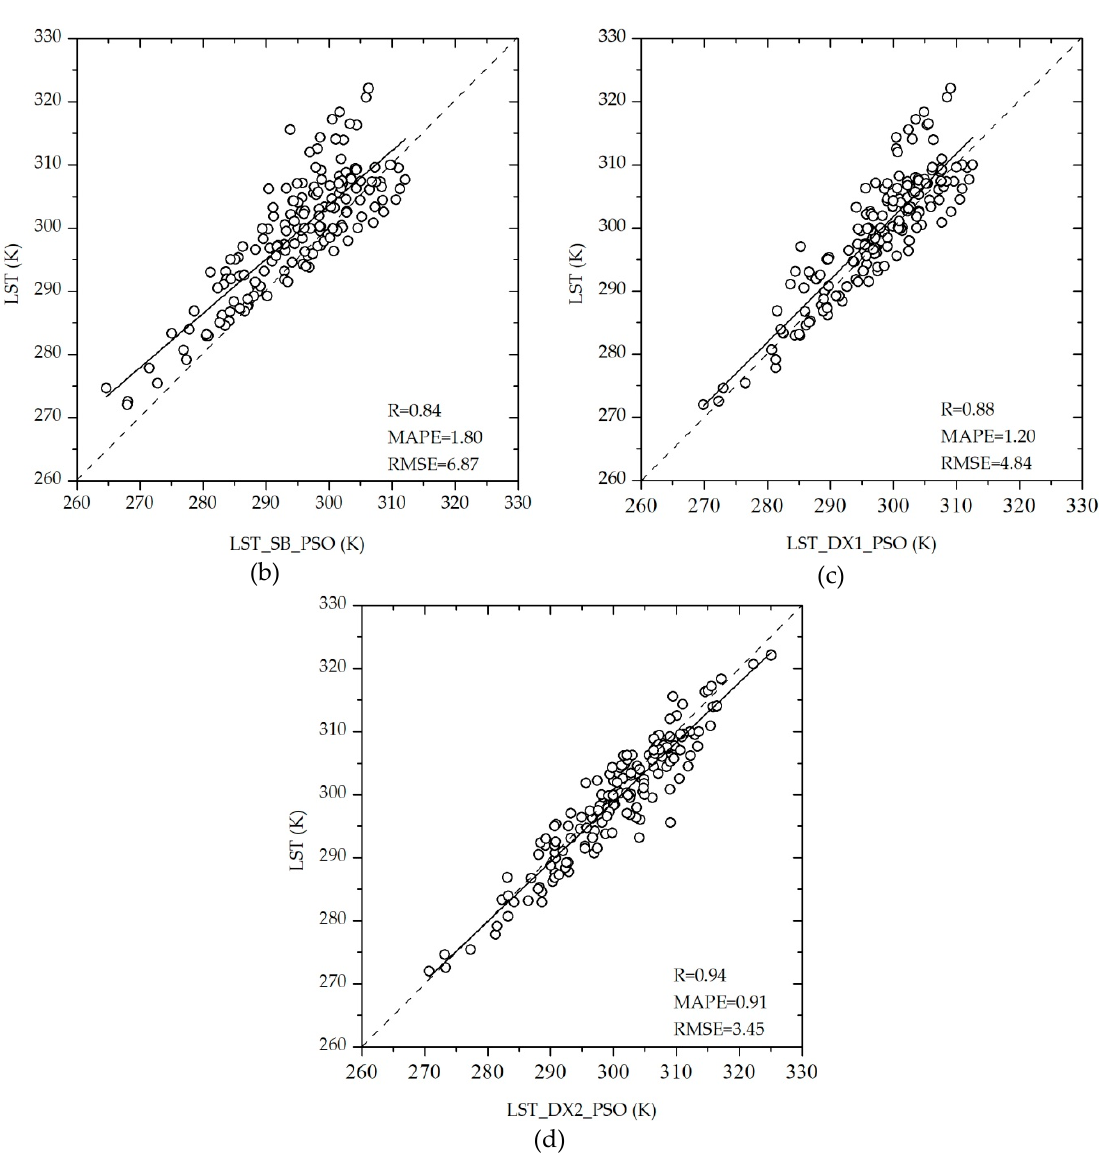
Figure 10 . The comparison of LST retrieved by the optimized split-window algorithm and measured values; ( a ) is the time series, ( b ) is the LST results based on the SB emissivity model, ( c ) is the LST results based on the DX1 emissivity model, and ( d ) is the LST results based on the DX2 emissivity model.